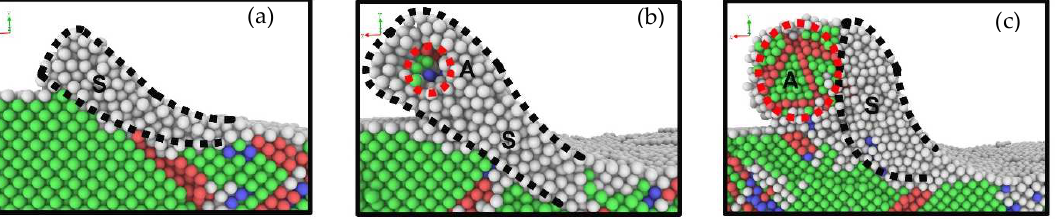
Figure 9. The crystal structure change diagram of the spherical chip formation process. ( a – c ) is a continuous process of spherical chip formation, green, red, blue and white are FCC, HCP, BCC and other structural atoms respectively.